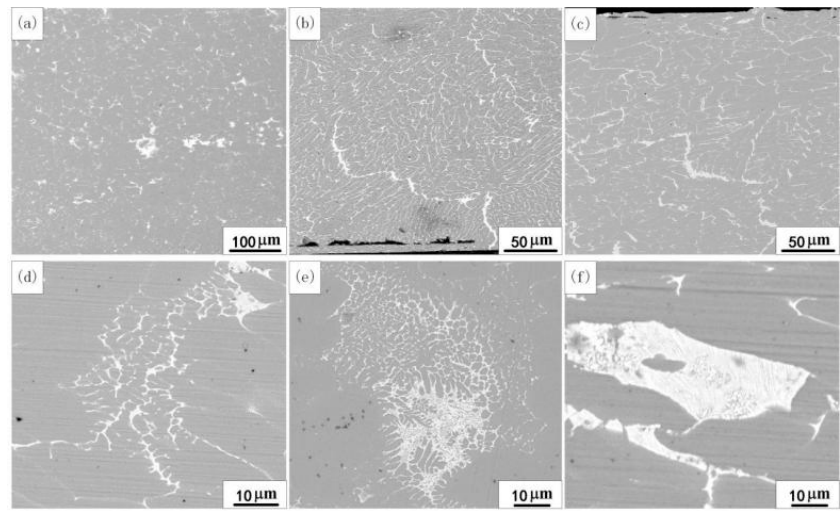
Figure 2. The primary phases of as-cast ACMZ. ( a ) The central segregation region; ( b ) The prefer- entially solidified surface; ( c ) The later solidified surface; ( d ) Primary phases near the preferentially solidified surface; ( e ) Primary phases between the central segregation region and the preferentially solidified surface; ( f ) Primary phases near the later solidified surface.